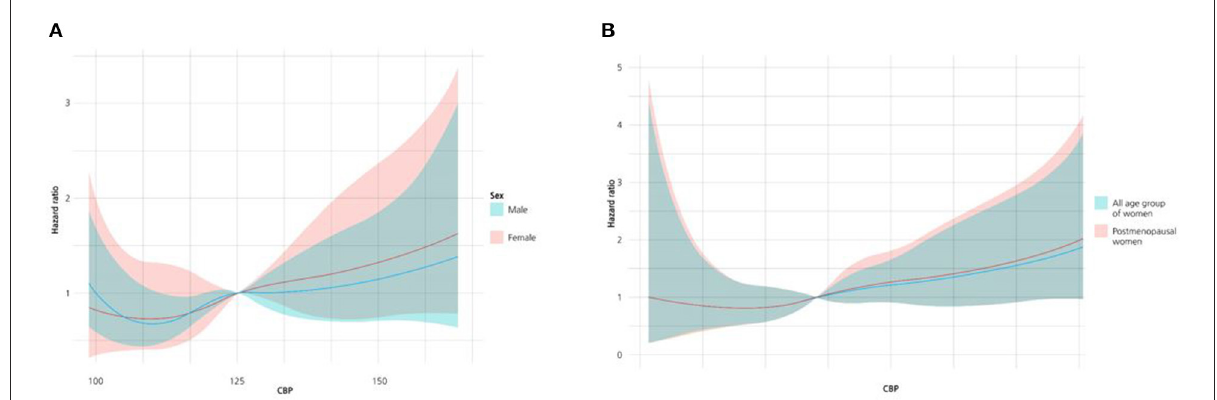
FIGURE1 (A) Restricted cubic spline curve of cumulative incidence of the primary outcome according to the entire age group of men (red) and women (blue). (B) Restricted cubic spline curve of cumulative incidence of the primary outcome according to all age group of women (blue) and group of postmenopausal women